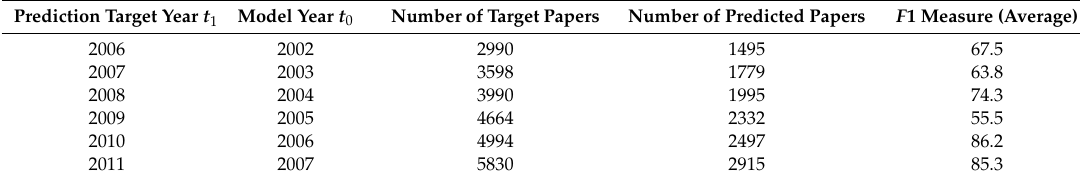
Table 3. Evaluation results for each year.